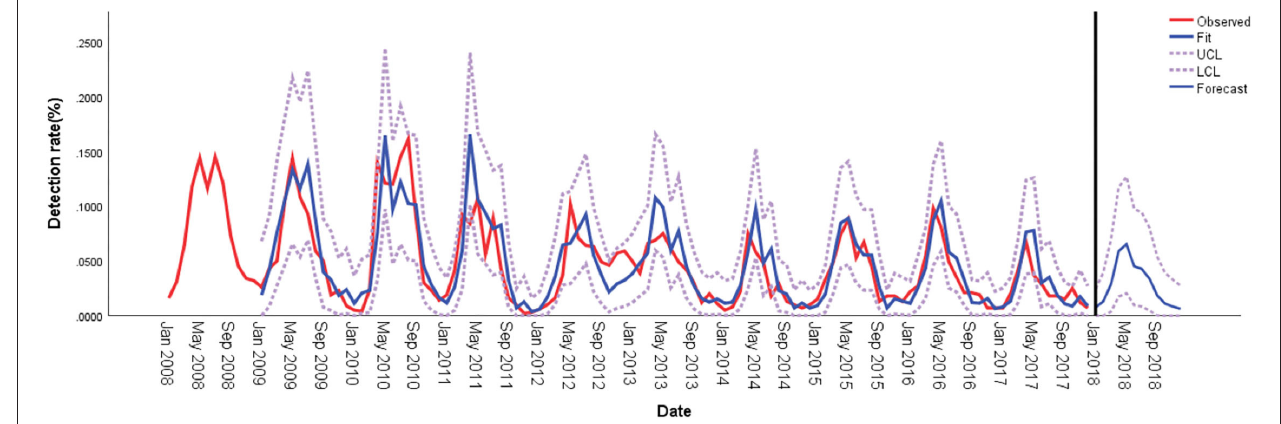
FIGURE 2 | Comparison of HPIV-3 detection rates predicted using ARIMA and observed values in hospitalized children in Wenzhou, China. ARIMA, autoregressive integrated moving average; LCL, lower confidence limit; UCL, upper confidence limit.